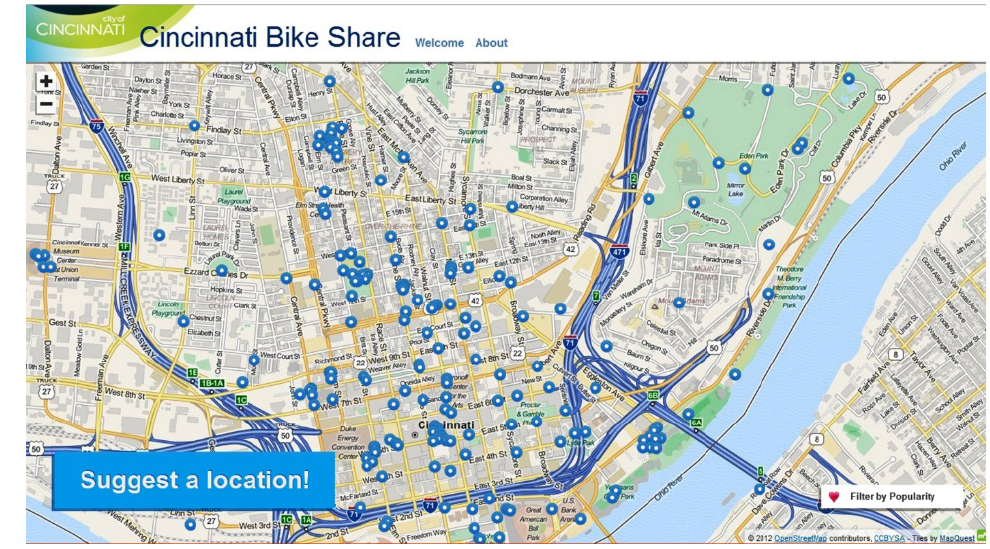
Figure 1. The City of Cincinnati’s interactive GIS website